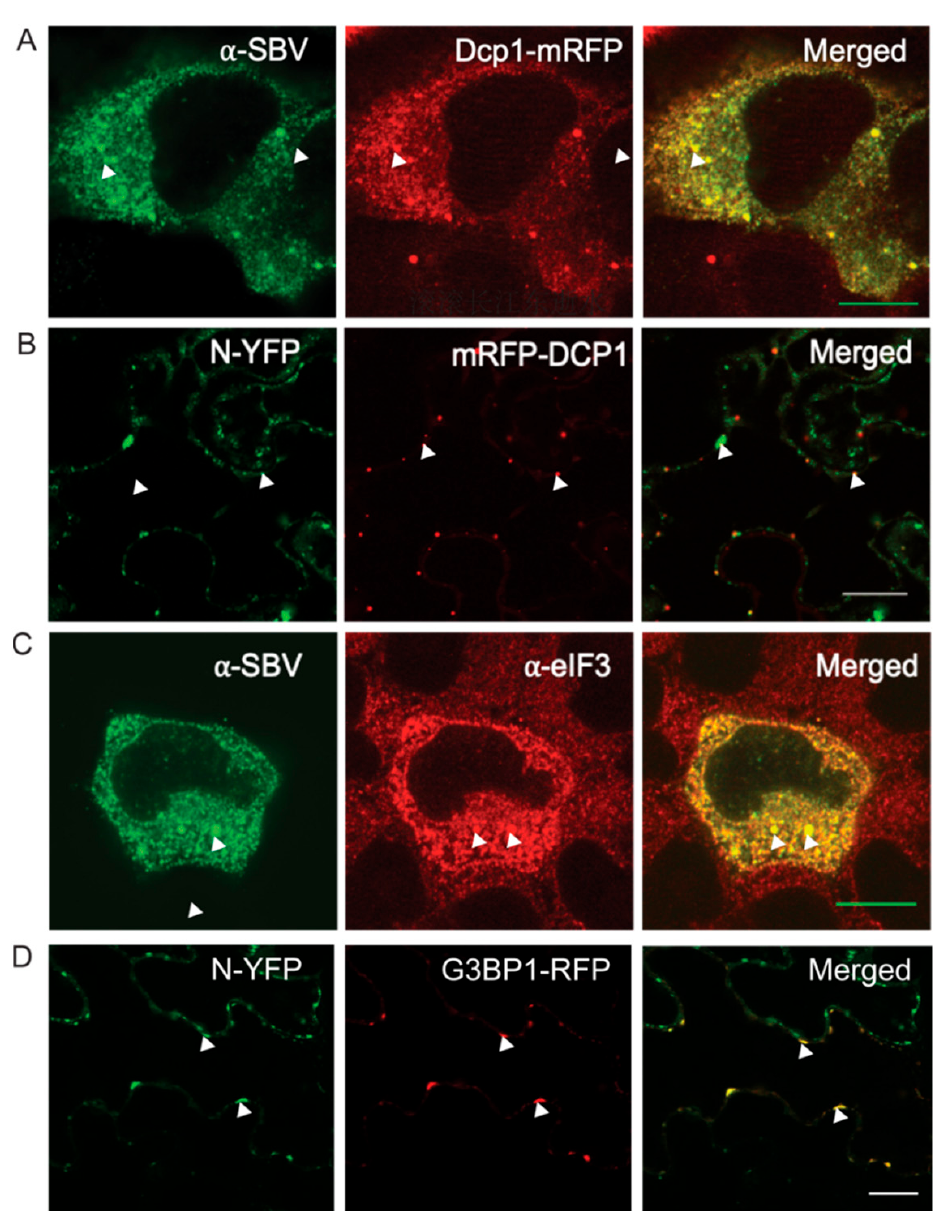
Figure 2. Localization of TSWV-N and SBV-N relative to PB/SG in virus infected cells. ( A ) HsDCP1- mRFP construct was first transfected to the cells and followed by SBV infection. SBV N was de- tected by immunostaining. ( B ) 5d post TSWV infection, TSWV-N-GFP and AtRFP-DCP1 were agro- infiltrated to infected leaves, confocal microscopy was observed at 48 hpi. ( C ) HsG3BP-mRFP construct was first transfected to the cells and followed with SBV infection. SBV N was detected by immunostaining. ( D ) 5d post TSWV infection, TSWV-N-GFP and AtRFP-G3BP1 were agro-infiltrated to infected leaves, and subjected to heat stress for SG-induction. Confocal fluorescence microscopy was performed at 48 hpi. Scale bar is 10 µ